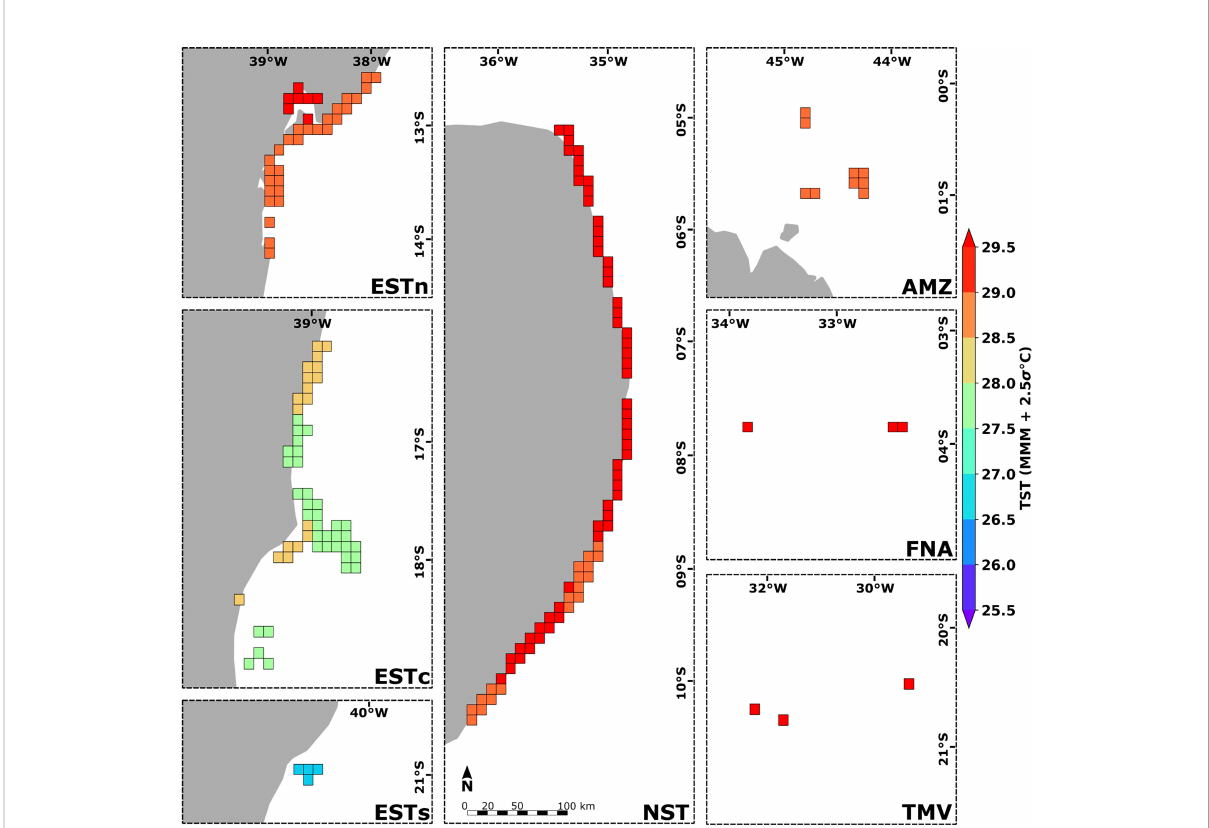
FIGURE 8 Spatial distribution of thermal stress thresholds (TST) calculated for the 180 reef sites along the Brazilian continental margin (in gray). Ecoregions: Eastern-south (ESTs); Eastern-center (ESTc); Eastern-north (ESTn); Northeastern (NST), Amazon (AMZ), Fernando de Noronha-Atol das Rocas (FNA), Trindade-Martim Vaz Islands